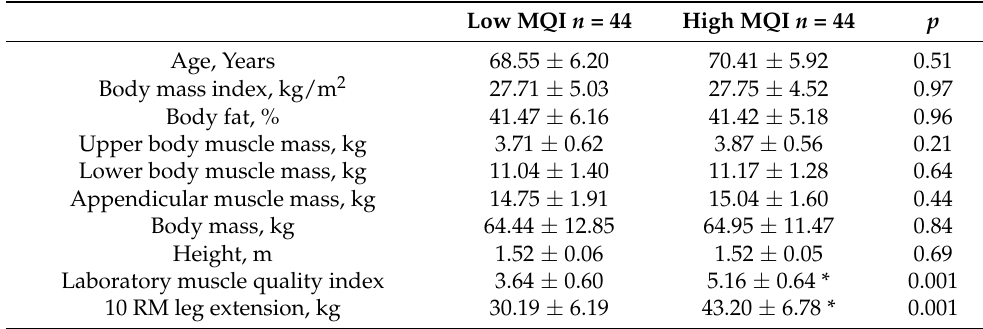
Table 1. Laboratory muscle quality participants